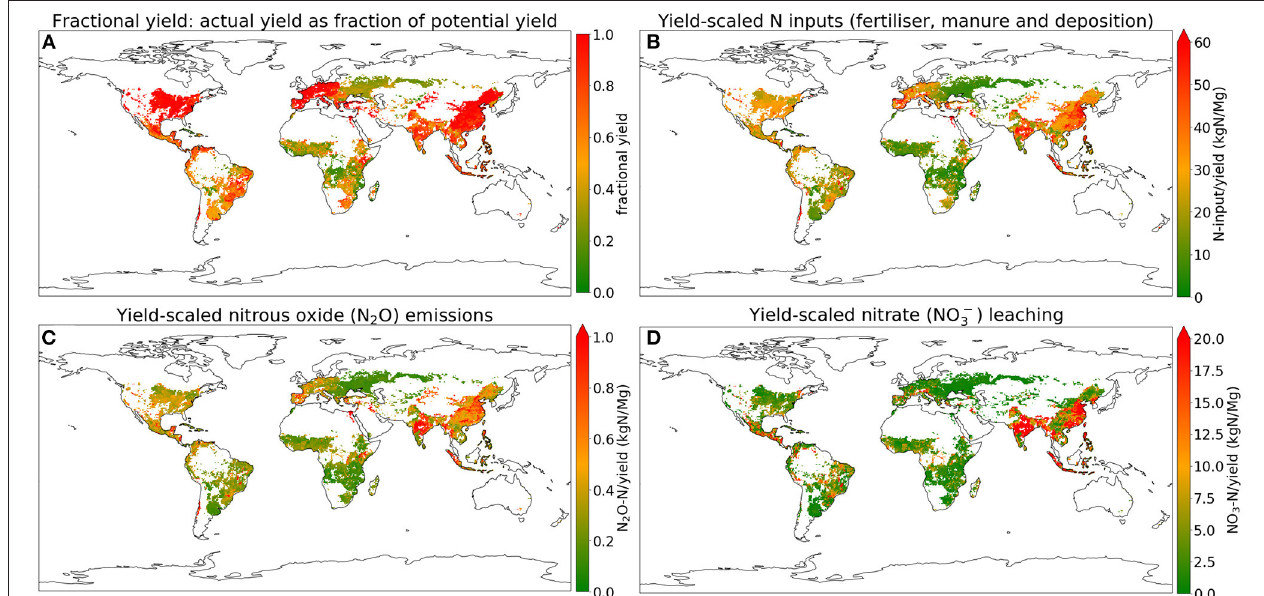
FIGURE 1 | Simulated yields, N inputs and N losses associated with maize cultivation in conditions typical of the year 2015. Simulations were performed on a 0.5 ◦ global grid using the biogeochemical model LandscapeDNDC. (A) Fractional yield (actual yield/potential yield, where potential yield is defined as the maximum attainable yield in conditions of nutrient sufficiency). (B) Yield-scaled N-inputs (synthetic fertilizer, manure, and deposition). (C) Yield-scaled nitrous oxide (N 2 O) emissions (direct and indirect). (D) Yield-scaled nitrate (NO − 3 ) leaching.